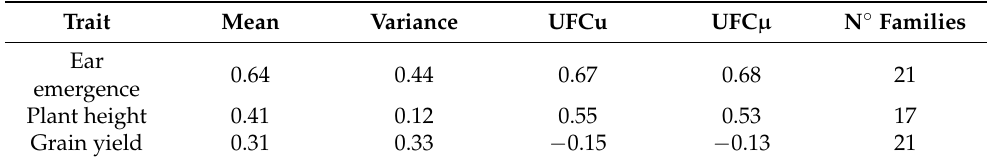
Table A1. Prediction abilities of population parameters in a scenario where the test set corre- sponds to the final breeding cycle of 2019 and the training set corresponds to a combination of all previous